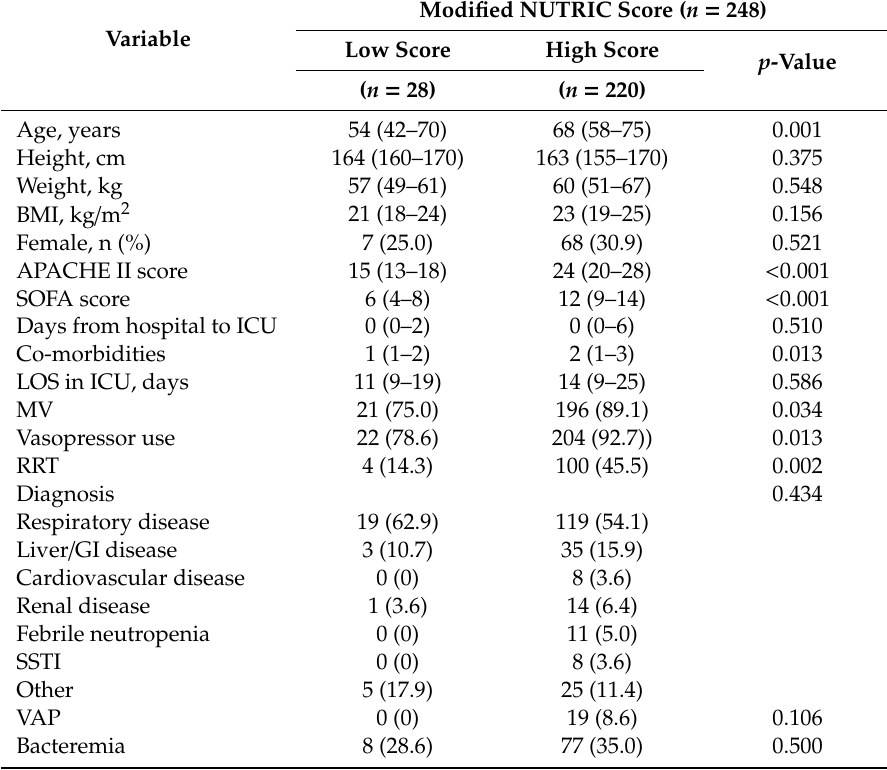
Table 1. Patient characteristics according to modified NUTRIC